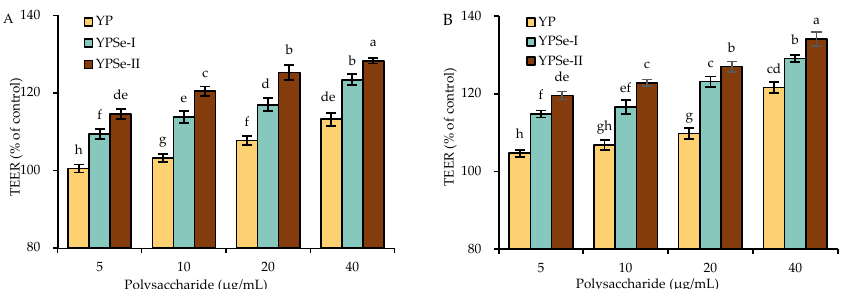
Figure 2. Time-responses of the TEER of IEC-6 cells treated with YP, YPSe-I, and YPSe-II for 12 ( A ) and 24 h ( B ). Different lowercase letters above the columns denote a significant difference in the one-way ANOVA means ( p < 0.05).